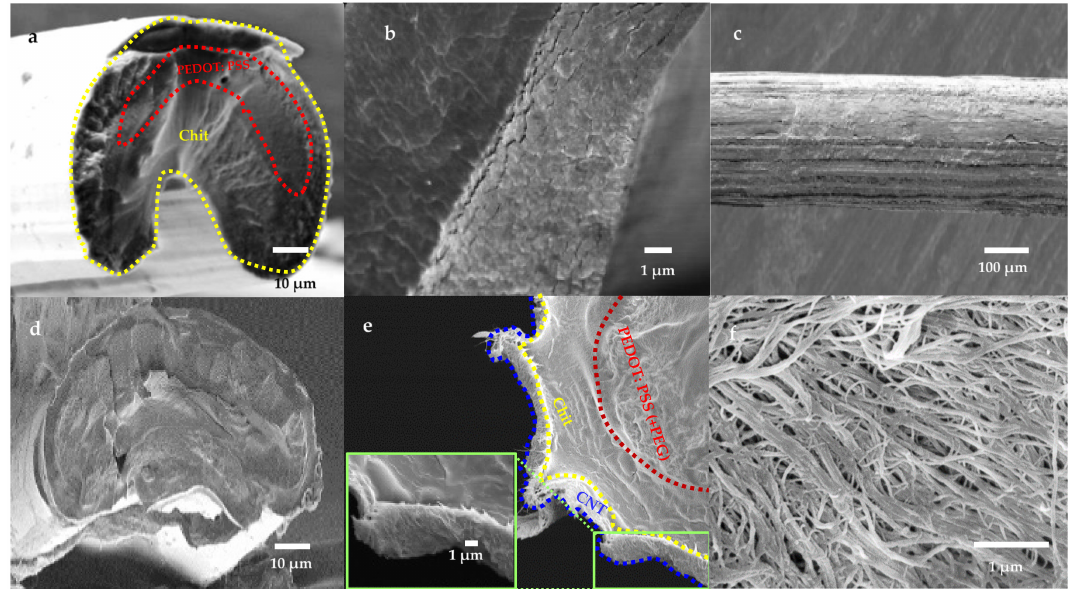
Figure 6. SEM images of ( a , d ) cross section, ( b , e ) higher magnifications and ( c , f ) surface pattern of as-prepared coaxial Chit-PEDOT and triaxial CNT-Chit-PEDOT fibers, respectively (the dashed lines are included to aid the reader in observing three different layers).